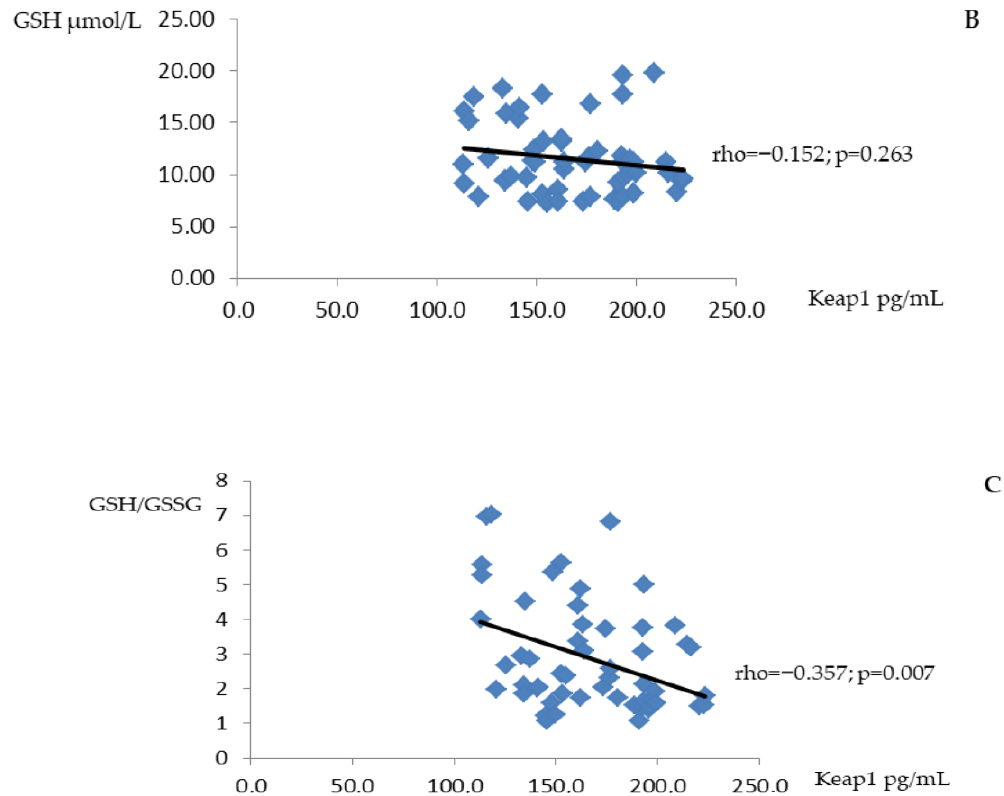
Figure 2. Scatter plot for the relationships between Keap1 and GSSG ( A ), GSH ( B ), as well as R-index ( C ) in women with